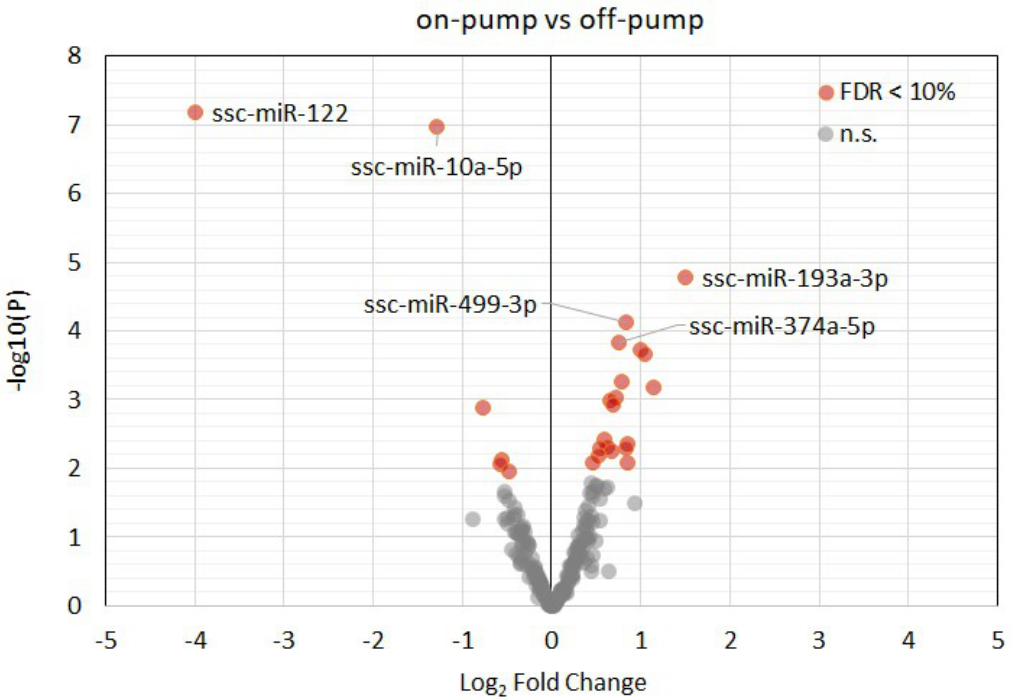
Figure 6. Volcano plot of the detected myocardial miRNAs in pigs with off-pump compared with on-pump protocols. Upregulated and downregulated miRNAs are in red. Top 5 statistically significant (adjusted p -value (FDR) < 0.1) miRNAs are depicted with their miRBase identifiers. FDR: false discovery rate.